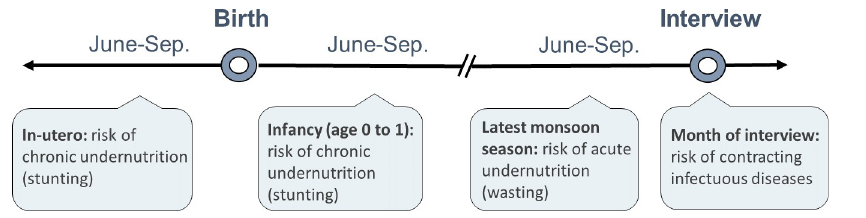
Fig 5. Critical periods of exposure to climate